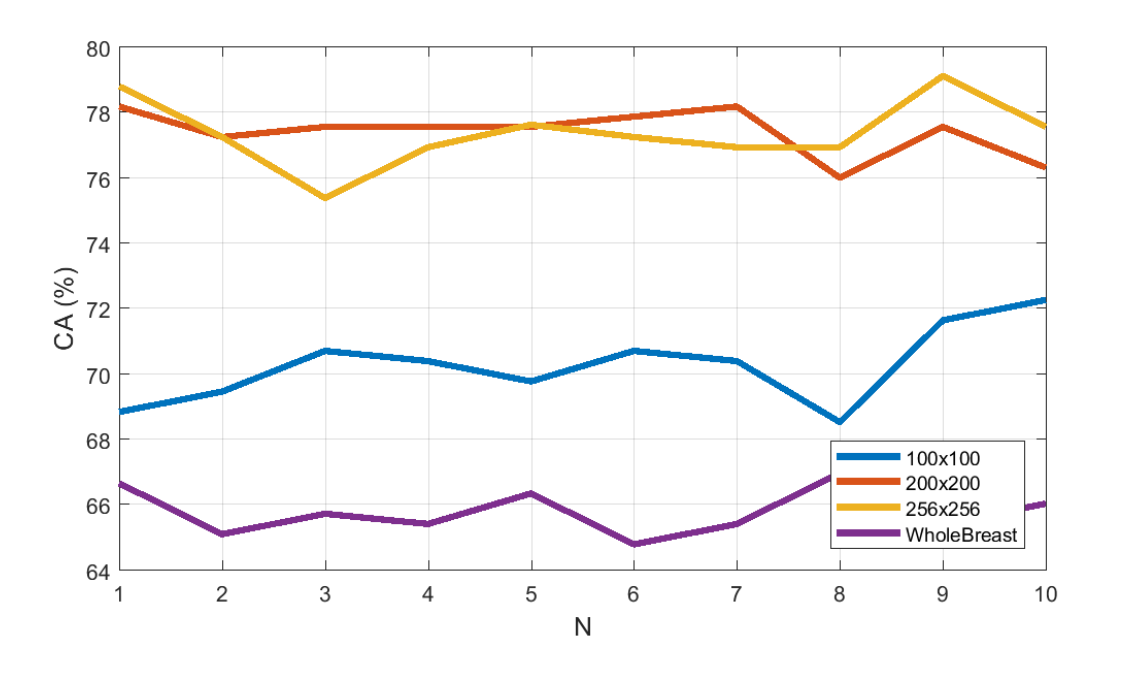
Figure 9. Classification accuracy as a function of ROI size (N indicates a distinct run).